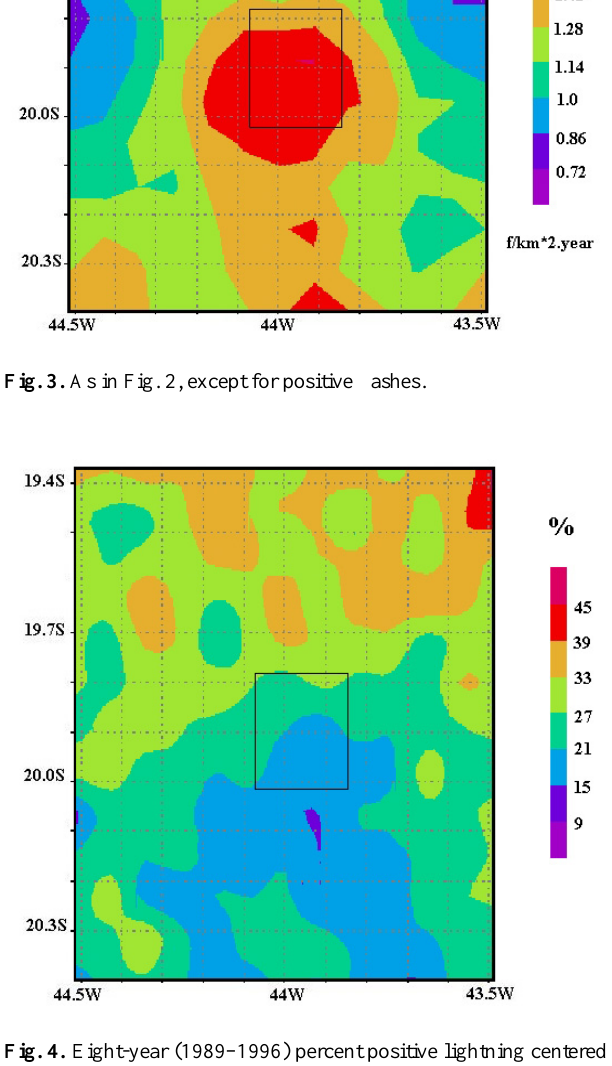
Fig. 4. Eight-year (1989–1996) percent positive lightning centered on Belo Horizonte (indicated by a black rectangle), at a spatial resolution of